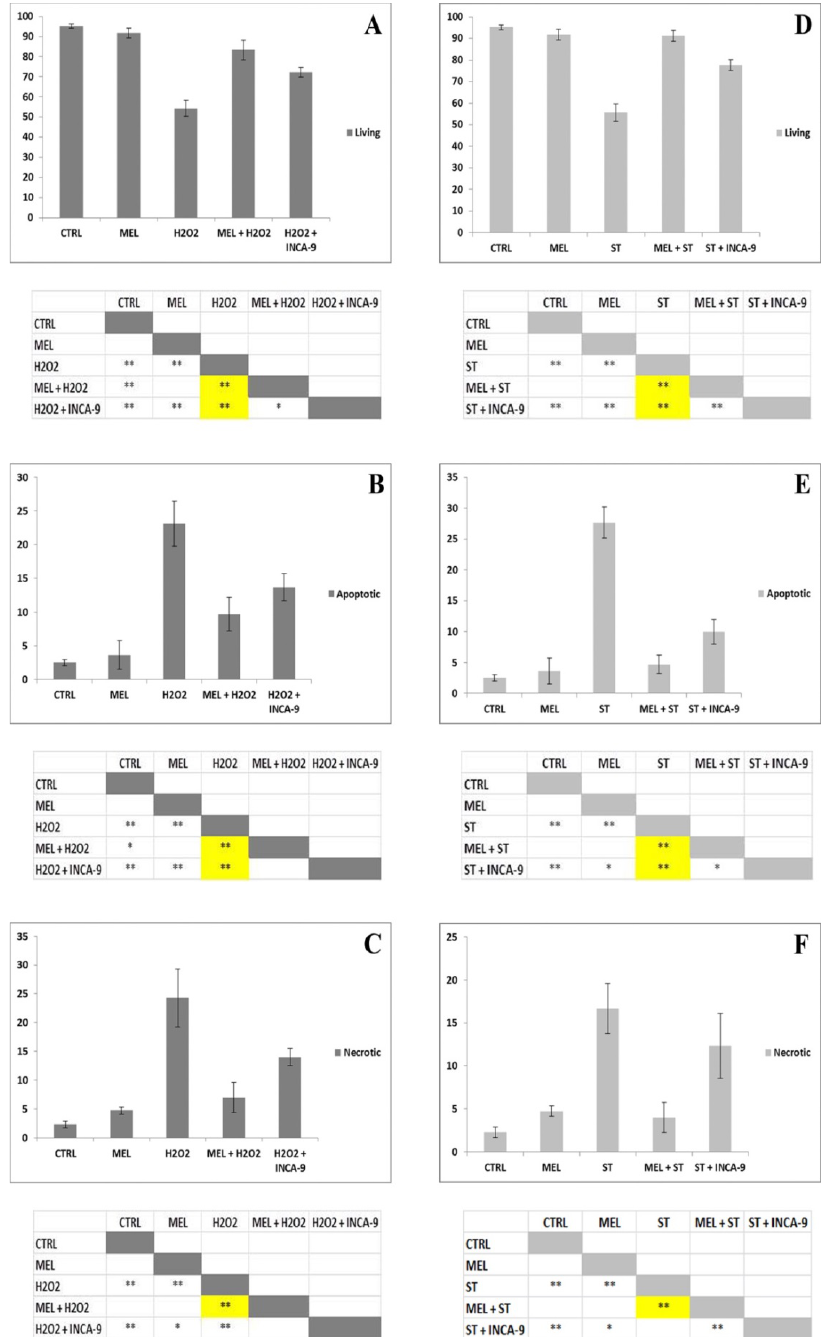
Figure 6. Percentage study of viable, apoptotic and necrotic cells based on Annexin V analyses. All data are expressed as mean values of percentages for each group ± DS. MEL significantly (yellow in the table) restore cell viability ( A , D ) and prevents apoptotic ( B , E ) and necrotic cell death ( C , F ), induced by H caspase-9